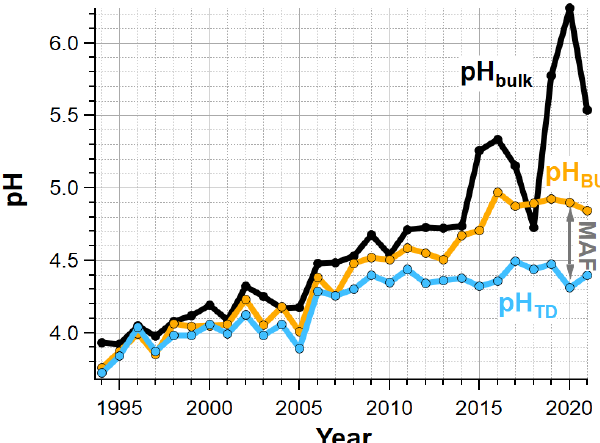
Figure 8. Annual median bulk cloud water pH (black) compared to estimated cloud droplet pH calculated from the bulk cloud water pH and measured Ca 2 + and Mg 2 + concentrations (pH TD , blue) and estimated cloud droplet pH calculated from measured SO 2 − and NH + concentrations (pH BU , 4